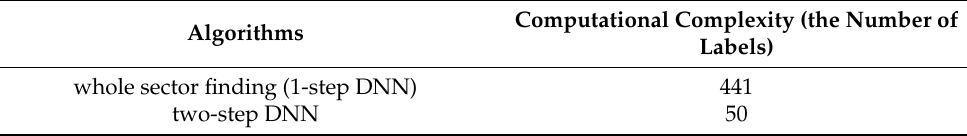
Table 2. Difference between the total zone and the calculations of the proposed algorithm.